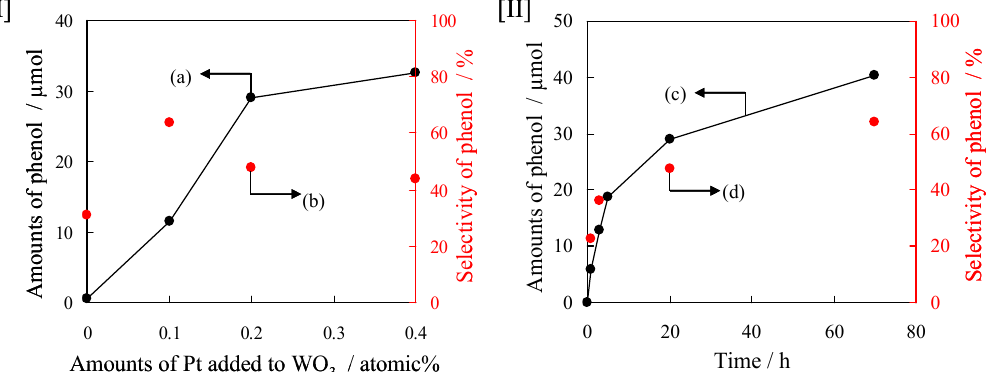
Figure 2. Dependence of loading amounts of Pt deposited on the WO 3 [ I ]; and reaction time profile on the Pt(0.2)-WO 3 [ II ] for hydroxylation of benzene to form phenol (yields: a, c; and selectivity: b and d) under visible-light irradiation.